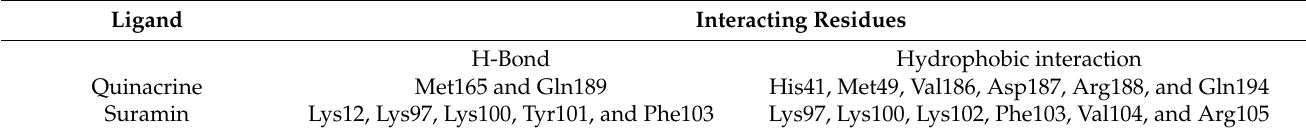
Table 3. SARS-CoV-2 3CL pro residues involved in forming H-bonds and hydrophobic contacts with quinacrine and suramin.